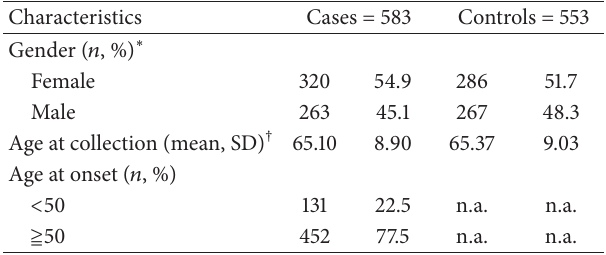
Table 1: Demographic characteristics of Parkinson’s disease (PD) cases and controls.